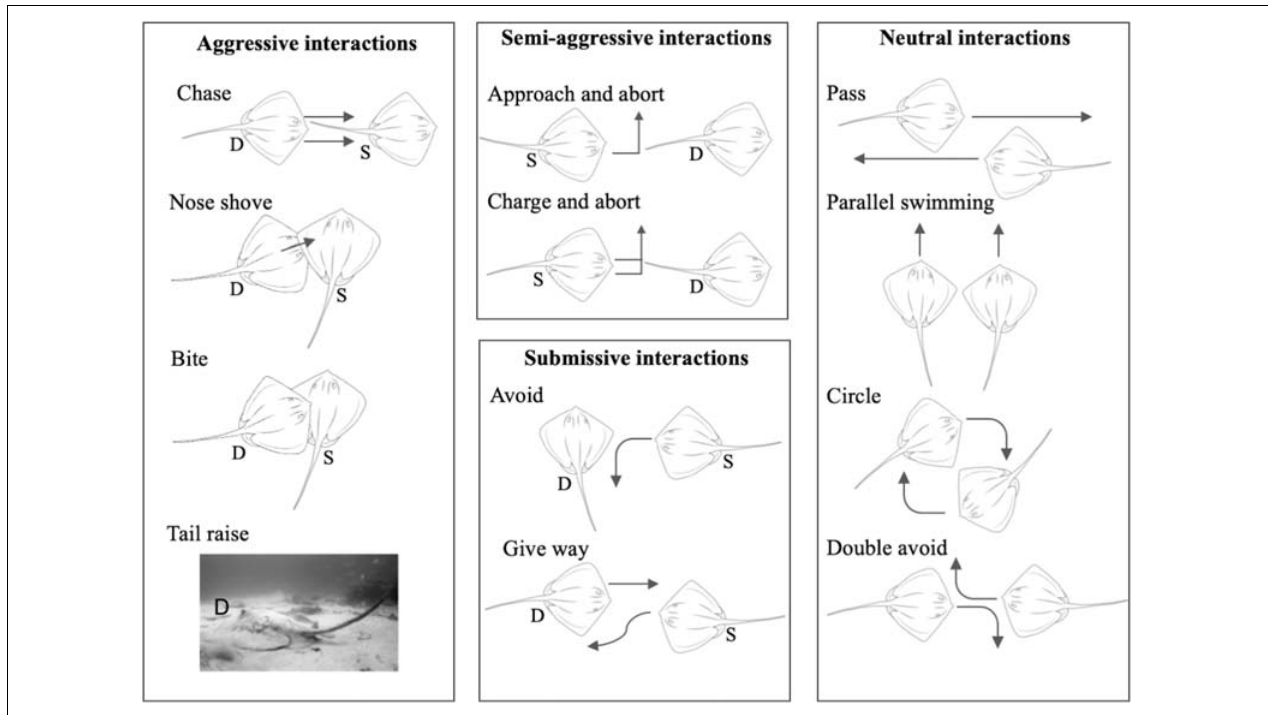
FIGURE 2 | Visual ethogram of dyadic interactions exhibited over simulated provisioning. Dominant individuals are marked “D” and submissive individuals are marked “S” for asymmetrical interactions. Full descriptions of interaction types are given in Supplementary Table 2